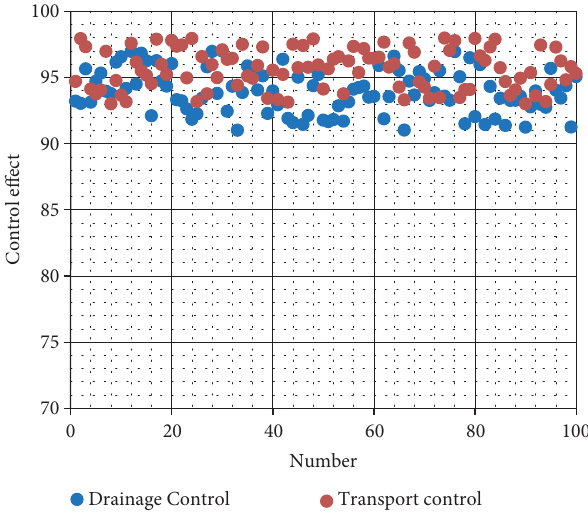
Figure 9: Effect verification of automatic control system of fully mechanized mining face in coal